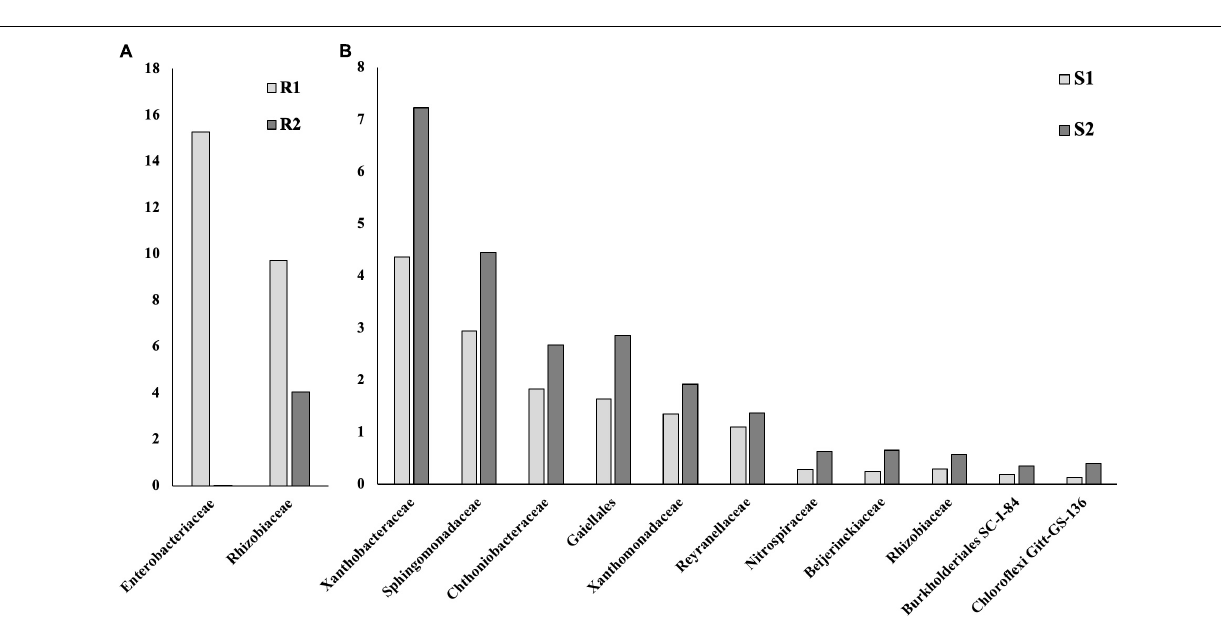
FIGURE 5 | Bacterial taxa that were differentially represented between roots (R), rhizospheres (RS), and soils (S) with and without inoculation. Based on the ALDEx2 Benjamini–Hochberg corrected p -value of the Kruskal–Wallis test. (A) Roots. (B)